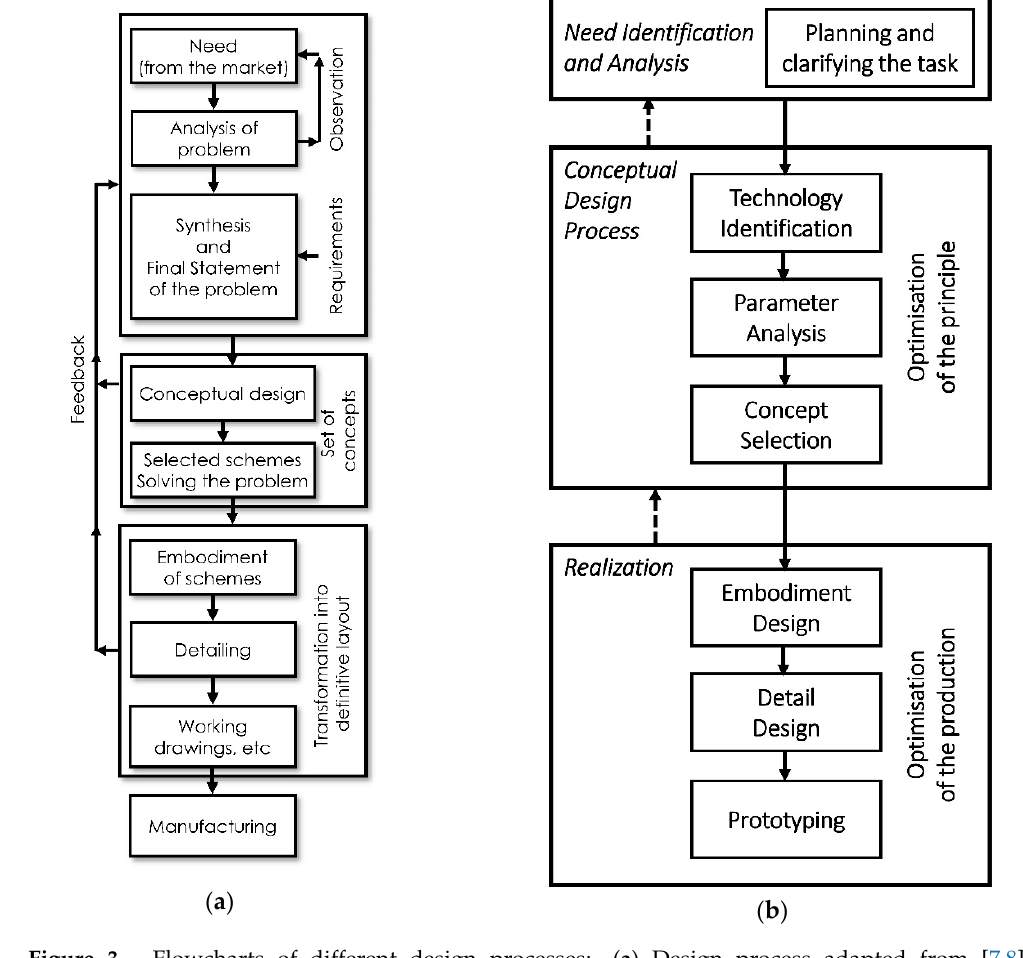
Figure 3. Flowcharts of different design processes: ( a ) Design process adapted from [7,8]; ( b ) Engineering design process adapted from